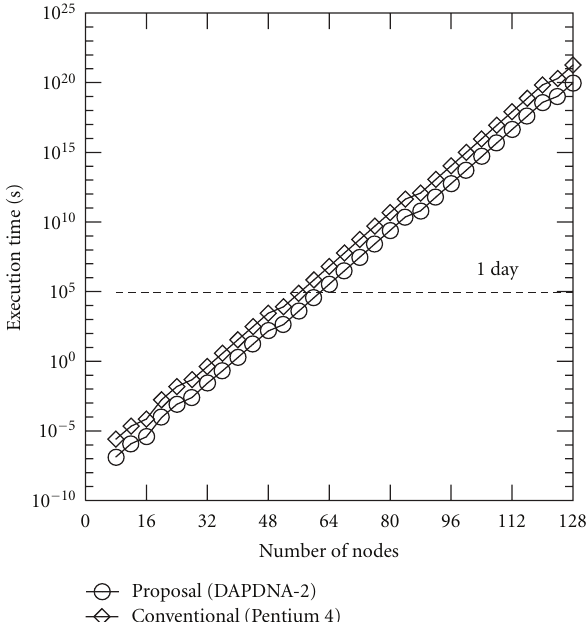
Figure 13: Execution time versus the number of nodes on the grid network model (theoretical